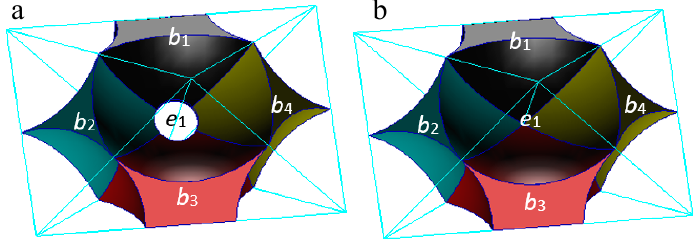
Figure 6. ( a ) Particles A and B are in contact and squeeze each other; ( b ) Particles A and B are not in contact, characterizing the void part in the void cell system. ( e , b are the edge and the body in the void cell system,